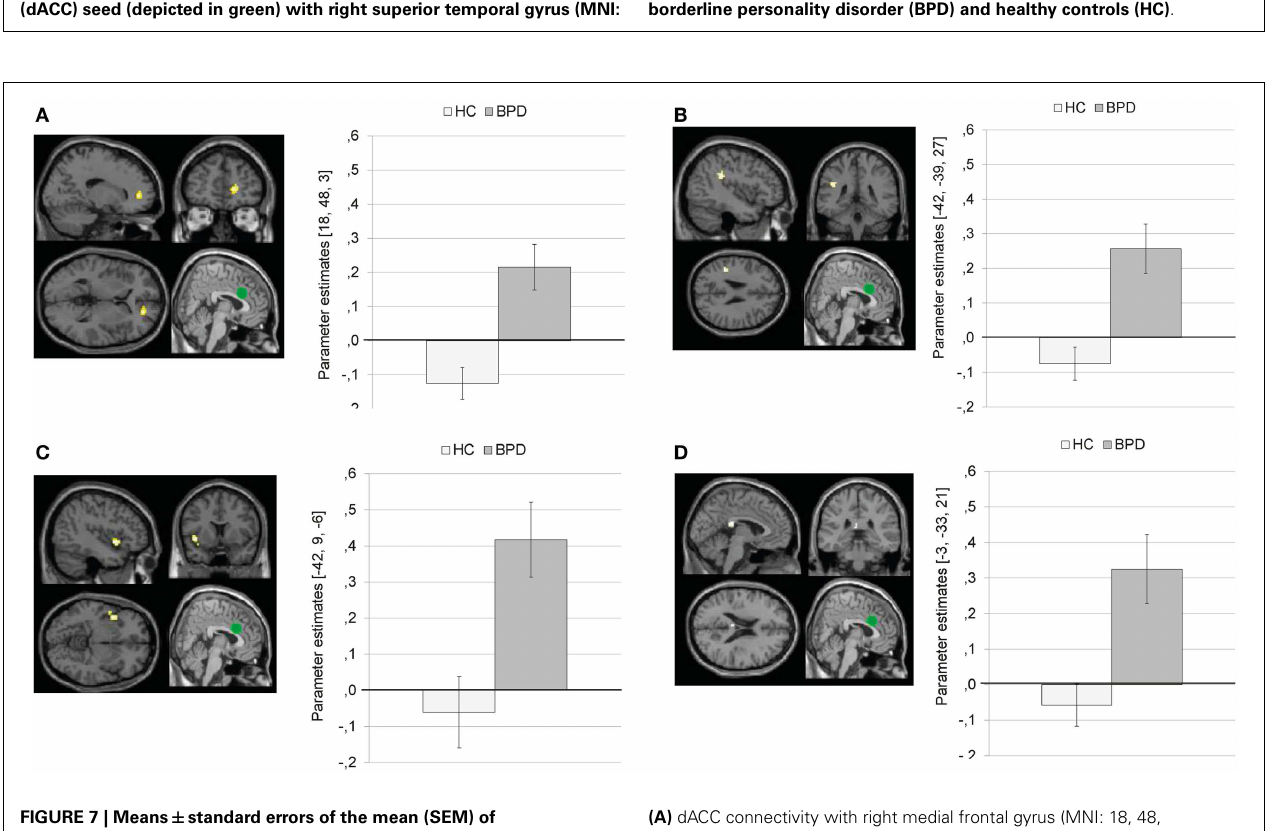
51, − 48, − 15) revealed by the interaction effect of group by valence of the 2 × 2 Full Factorial Model for dACC connectivity in patients with borderline personality disorder (BPD) and healthy controls (HC) .